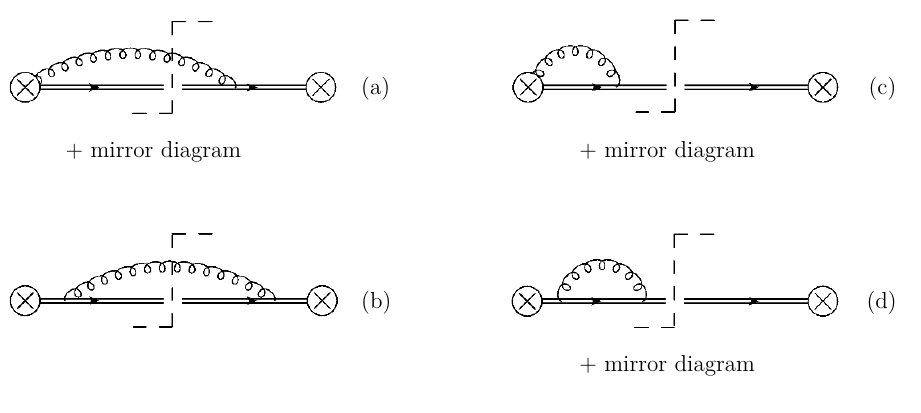
Figure 7 . One loop diagrams for the HQET jet